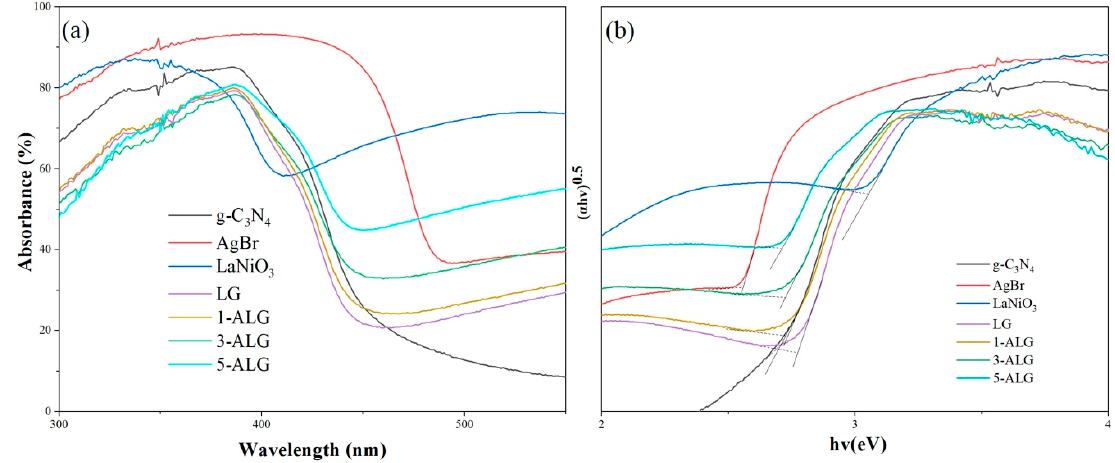
Figure 6. DRS spectra ( a , b ) the estimated band gap curves of all the samples obtained.